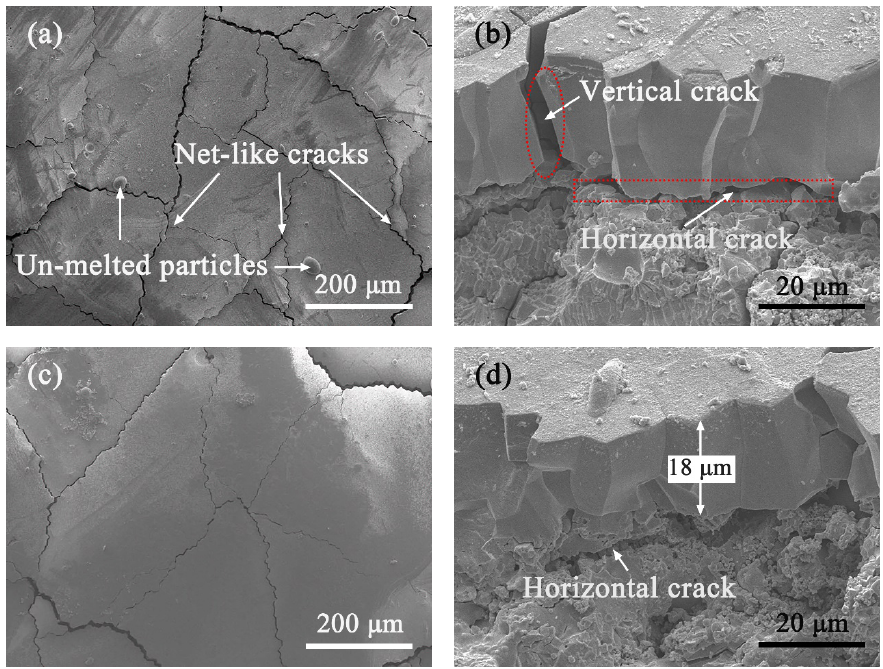
Fig. 2 (a, c) Surface and (b, d) fracture-section images of the laser glazed YSZ coatings: (a, b) LG-1, (c, d)